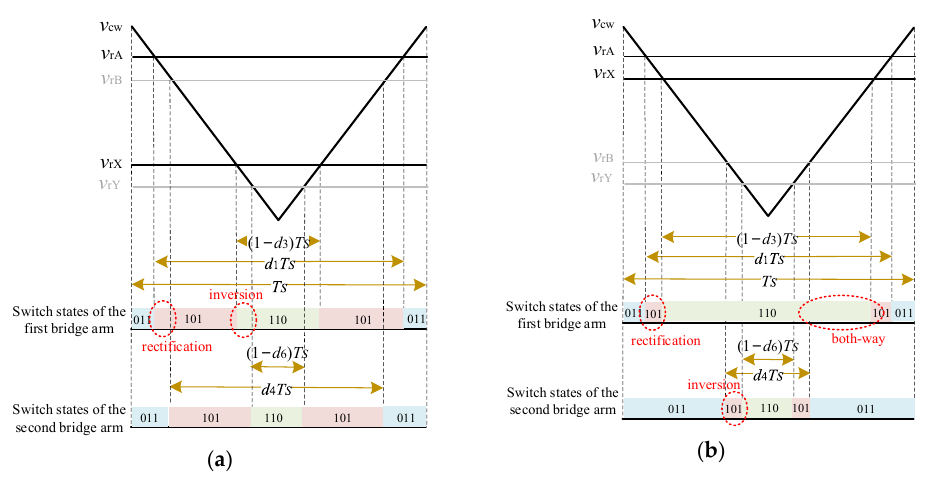
Figure 5. Schematic diagram of the switching state: ( a ) state A; ( b ) state B. v cw , v rA , and v rX were previously defined on paper, and v rB and v rY are the modulation references of the upper switch and the modulation references of the lower switch of the second bridge arm, respectively. d 1 , d 3 , d 4 , and d 6 denote the duty ratios of ST 1 , ST 3 , ST 4 , ST 6 , and T S is the switching period. From Figure 5a, it can be concluded that when the switching states of ST 1 ~ ST 6 are {101011}, the six-switch converter is in RS, and the state duration is ( d 1 – d 4 ) T S . When the switching states of ST 1 ~ ST 6 are {110101}, the six-switch converter is in IS, and the state duration is ( d 6 – d 3 ) T S . The rest of the switching states are in FS, and the state duration is (1 − d 1 + d 3 + d 4 − d 6 ) T S .